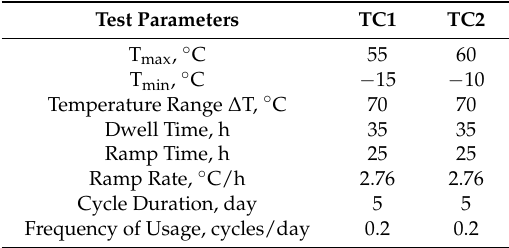
Table 2. Test parameters of the temperature cycling.